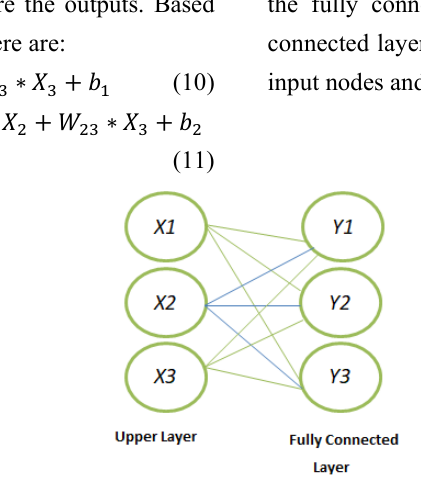
Figure 9 Forward calculation process of full connection layer